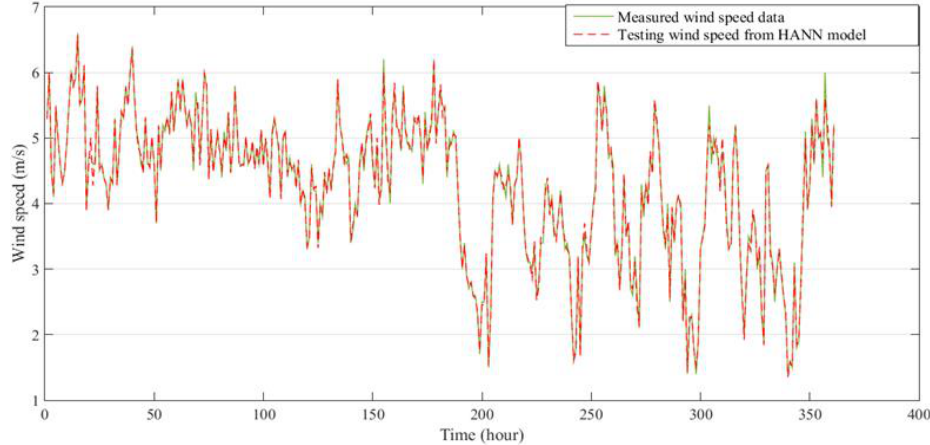
Figure 10. Comparison between measured and predicted wind speed for two weeks at Mersing in 2015, for validation of the HANN model.